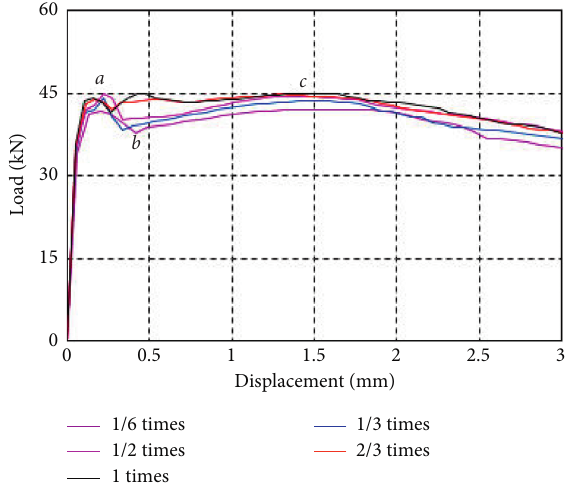
Figure 15: Load-displacement curves of M-1 element division